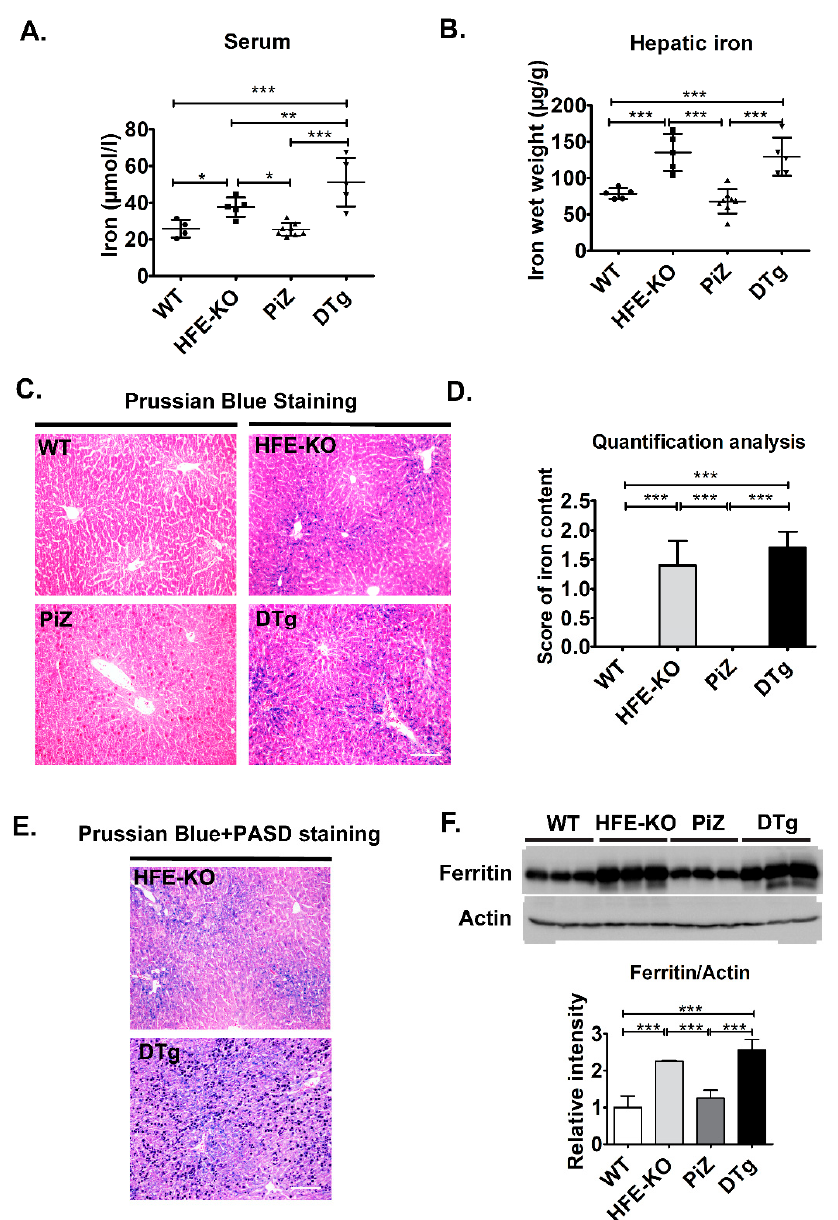
Figure 3. Overexpression of the Pi*Z variant of the human alpha1-antitrypsin (AAT) did not lead to iron accumulation in three months old mice. Serum ( A ) and hepatic ( B ) iron levels were measured and Prussian Blue staining ( C ) with morphometric quantification ( D ) was carried out in non-transgenic (WT) and Homeostatic Iron Regulator knockout ( HFE -KO) mice, mice overexpressing the Pi*Z variant of human AAT (PiZ) as well as double transgenic animals (DTg). Combined periodic acid-Schiff-diastase (PASD) and Perls Prussian Blue stainings ( E ) visualize the location of iron and AAT deposits. Immunoblotting and subsequent morphometric quantification assessed hepatic ferritin levels compared to actin, that was used as a loading control ( F ). Results are shown as mean ± SD (n ≥ 4 per group). Scale bar: 100 µ m. * p < 0.05, ** p < 0.01, *** p <